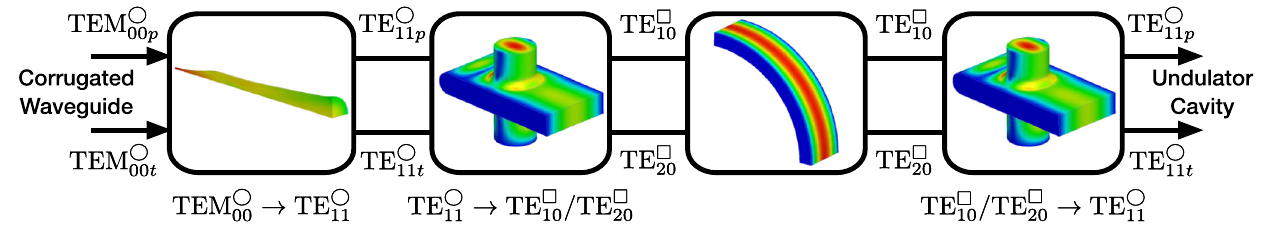
FIG. 14. Coupling system schematic, adapted from Toufexis et al.